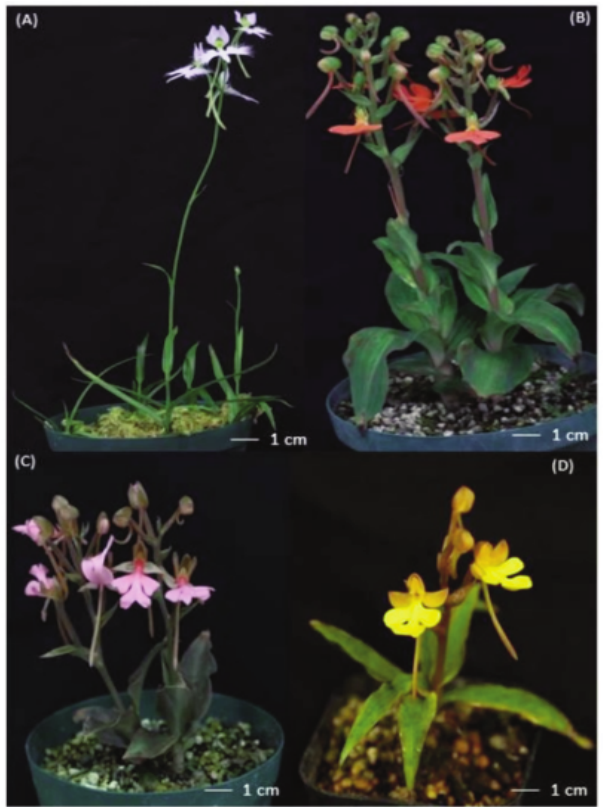
Fig. 1 ­ Plant morphology of Habenaria species used in this study. (A) H. radiata ‘Aoba’, (B) H. rhodocheila complex (orange), (C) H. rhodocheila complex (pink), and (D) H. rhodocheila complex